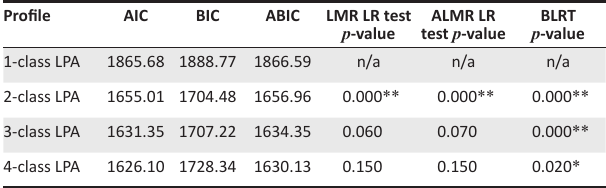
TABLE 5: Comparison of different latent class analysis models. Profile